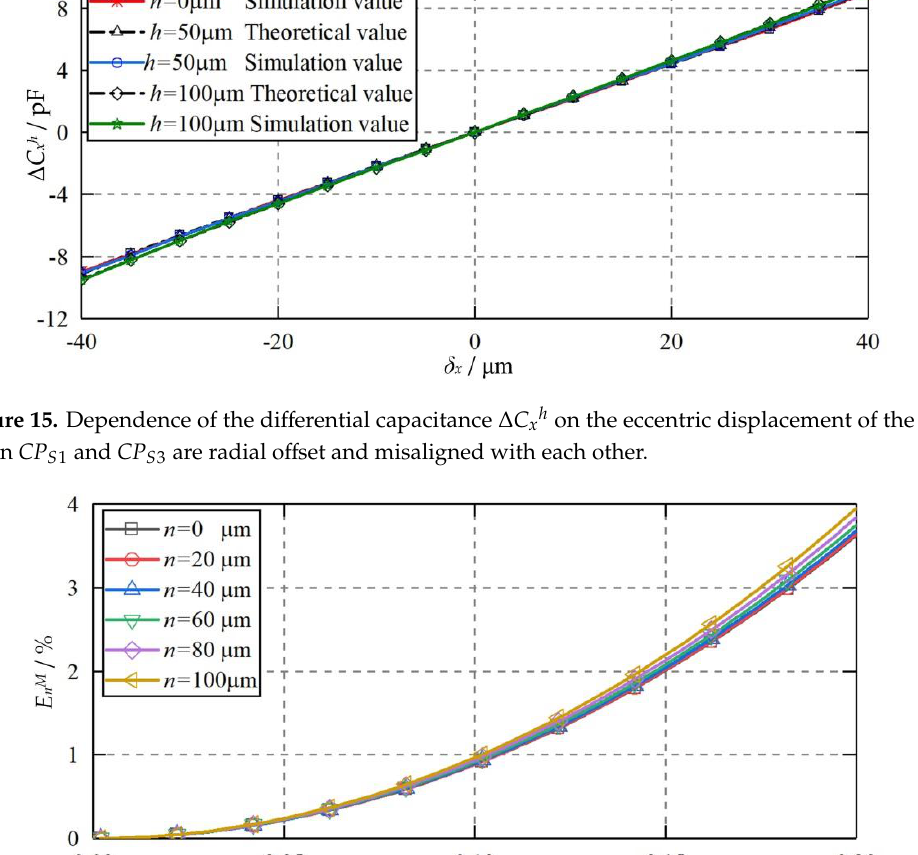
Figure 15. Dependence of the differential capacitance Δ C xh on the eccentric displacement of the ball when CP S1 and CP S3 are radial offset and misaligned with each other.